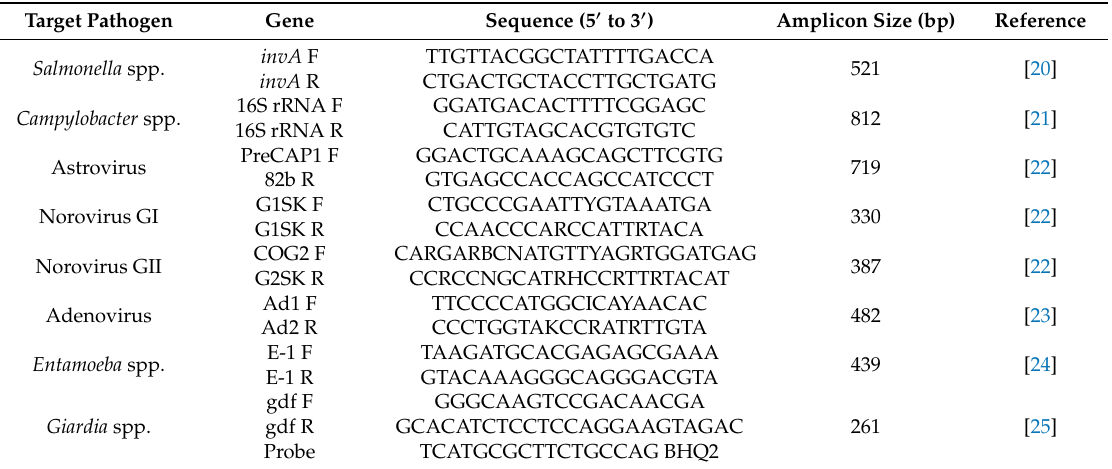
Table 1. Primers and probes used for molecular screening of a panel of seven enteropathogens